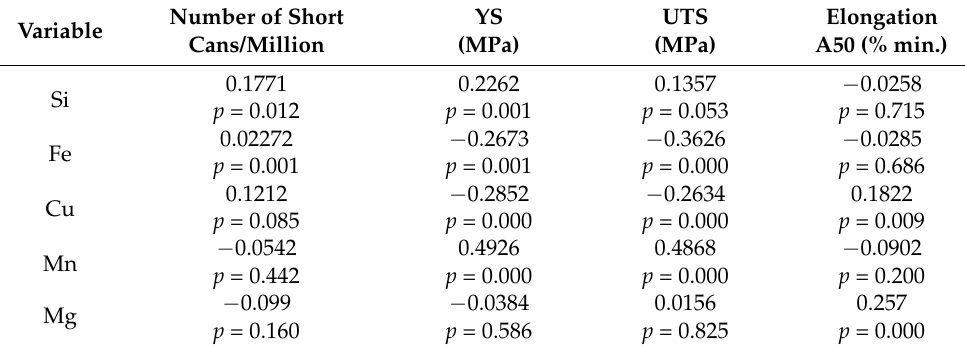
Table 4. Correlation between the chemical components and the index of short cans, YS, UTS and elongation.